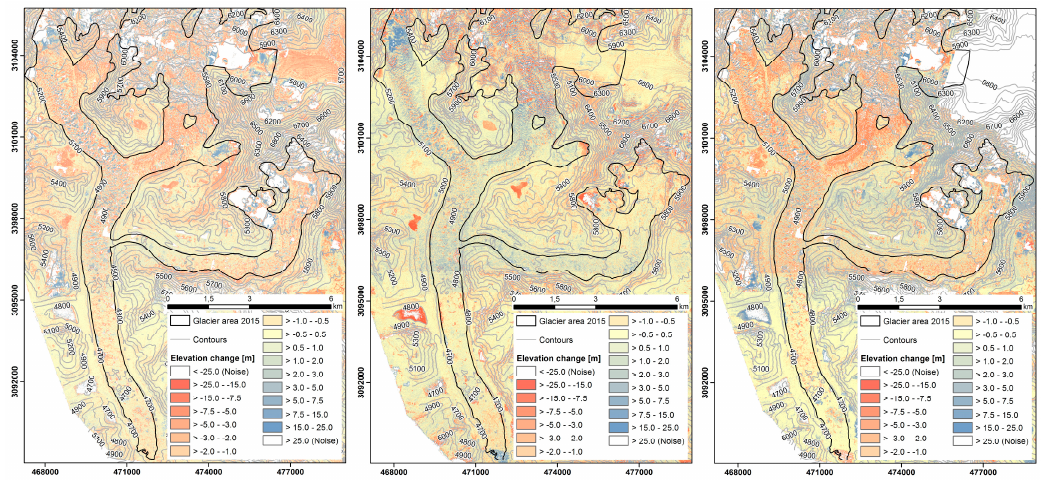
Figure 13. One-year winter and summer surface elevation change of the Ngozumpa glacier. UTM 45 N.